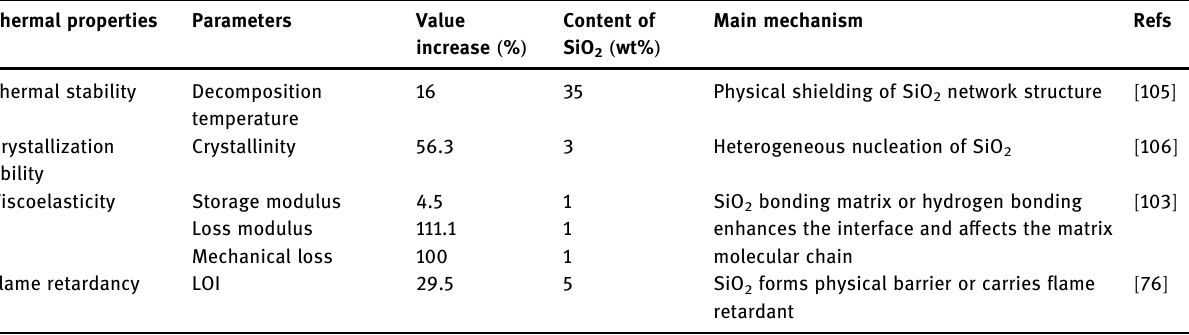
Table 2: Comparative parameters of thermal properties Thermal properties